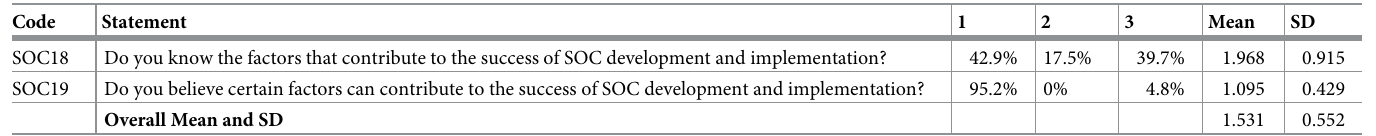
Table 10. Questionnaire on the general success factor for SOC.